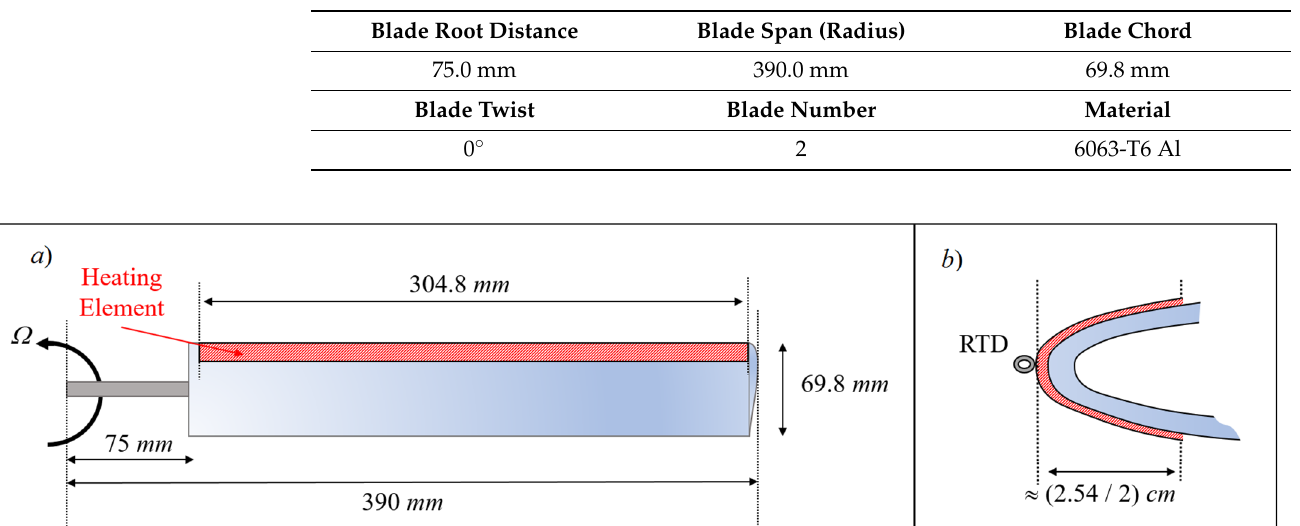
Figure 3. Sketch with Dimensions of Blade and Heating Element: ( a ) Top View and ( b ) Side View.